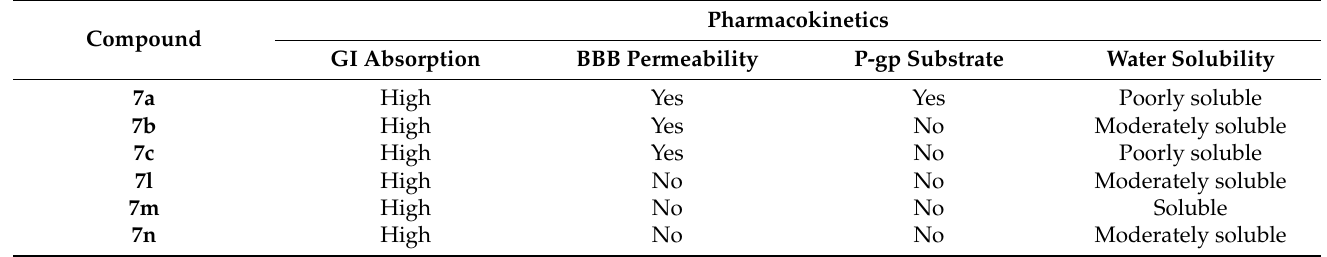
Table 17. Some ADME parameters of investigated derivatives (according to SWISSADME server).